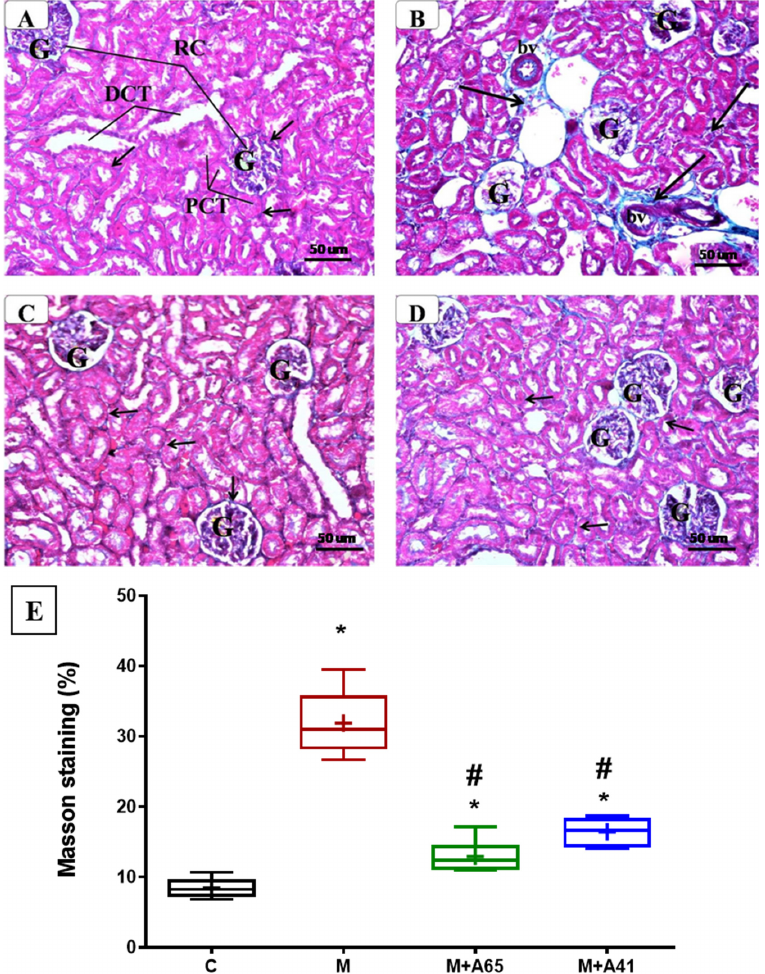
Figure 6. Representative photomicrographs of renal cortex of different groups stained with Masson’s Trichrome. Notice the marked increase of collagenous fibers ( ↑ ) in the kidney of metabolic syndrome ( B ) around the glomeruli (G) and tubules (PCT, DCT) as compared to the control ( A ). In contrast, AM6545-treated metabolic syndrome ( C ) and AM4113-treated metabolic syndrome ( D ) showed a noticeable reduction of collagenous fibers. (Masson’s Trichrome, A, B, C & D × 200). ( E ) shows the quantification of Masson’s Trichrome staining expressed as a %. Results are shown as box plots and the mean is shown as (+) ( n = 8). * Significantly different from “C” at p < 0.05, # Significantly different from “M” at p <